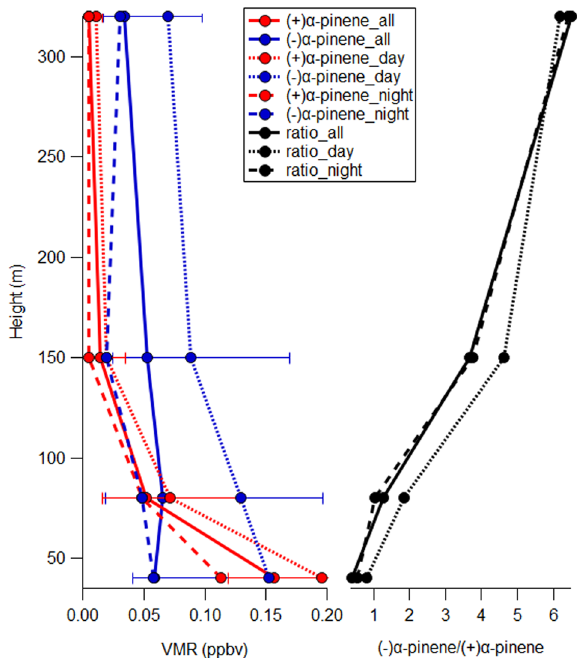
Fig. 2 Vertical pro fi le of ( − )- α -pinene and ( + )- α -pinene volume mixing ratio measured at 40, 80, 150, and 320 m along the ATTO tower. Sampling was conducted every 3 h for 10 days during the dry season 2017. Data points are median values of the measurements taken. Daytime values refer to samples taken between 8:00 and 17:00, while nighttime values refer to samples taken between 20:00 and 5:00 (all times are local). Sunrise is usually around 5:00 – 6:00 and sunset around 17:00 – 18:00. Error bars are 25 and 75 percentiles of the measurements (at 40 m the 75 percentile is 0.39 ppbv and 0.29 ppbv for ( + )- α -pinene and ( − )- α -pinene, respectively). The right panel shows the chiral ratio (here as ( − )- α -pinene/ ( + )- α -pinene) median values for the same sampling heights. In the 1:1 ratio the mixture is